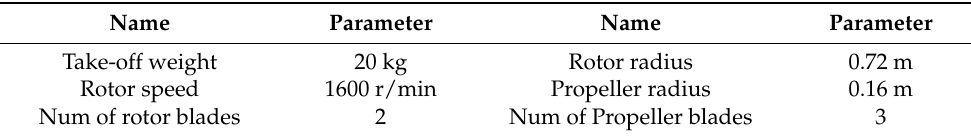
Figure 1. The compound unmanned aircraft. Table 1. Main parameters of the UAV.